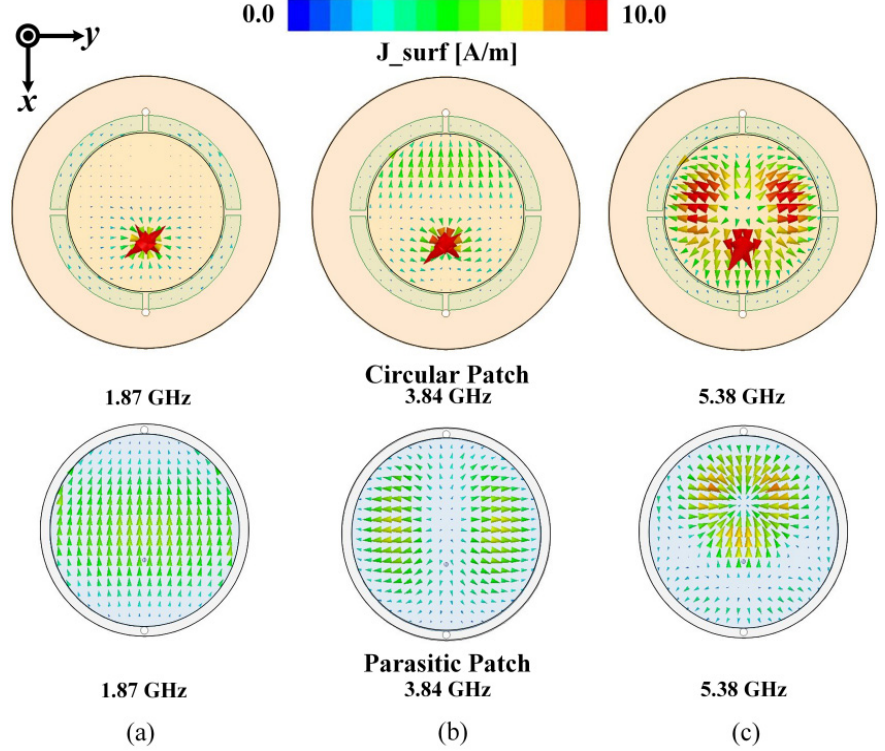
Figure 6. The simulated surface current distribution on the circular patch and parasitic patch of Ant. 3: ( a ) 1.87 GHz; ( b ) 3.84 GHz; ( c ) 5.38 GHz.